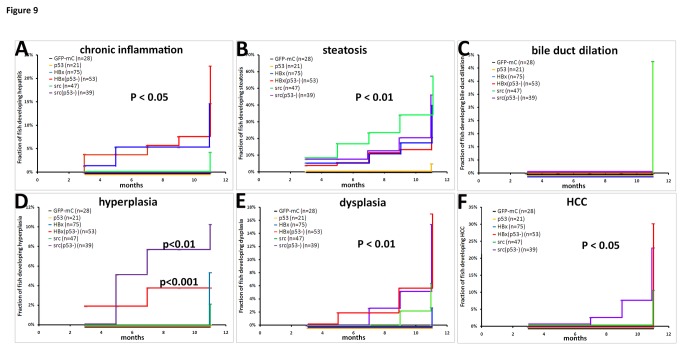
Cumulative frequency showing the fraction of fish that had developed the various liver diseases.The cumulative frequency of transgenic fish from multiple lines with chronic inflammation (A), steatosis (B), bile duct dilation (C), hyperplasia (D), dysplasia (E) and HCC (F) were analyzed by Kaplan-Meier analysis. The following different colors denote the different fish lines: black-GFP-mC control, orange-p53 mutant, blue-HBx transgenic fish in wild-type background, red-HBx(p53-) transgenic fish, green-src transgenic fish in wild-type background, and purple-src(p53-) transgenic fish. P<0.05 was considered to be statistically significant.